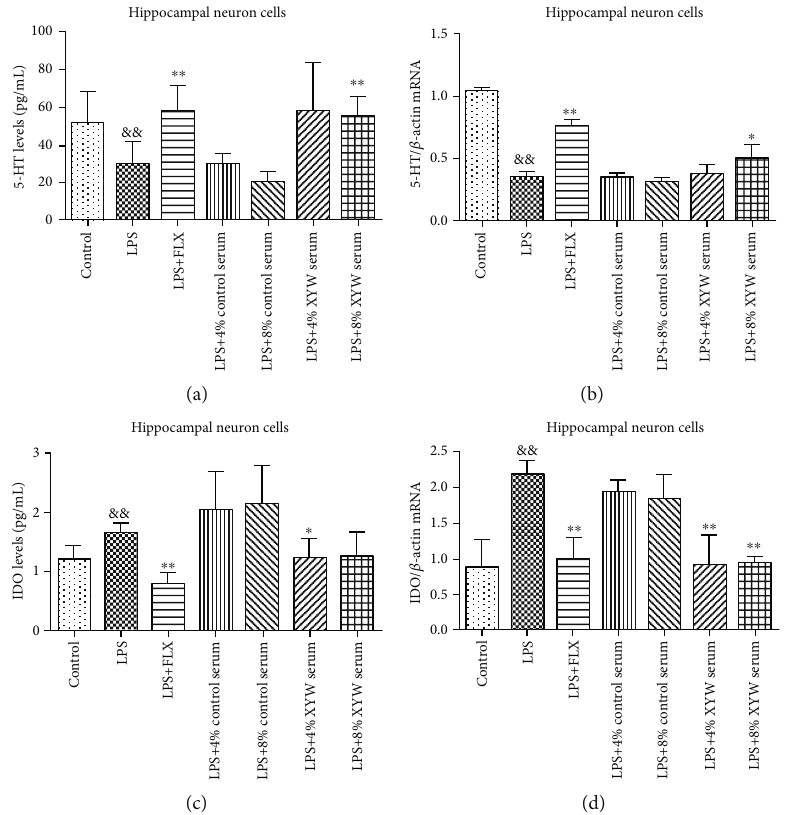
Figure 3: Xiaoyao Pill serum improved the expression of 5-HT and lowered the expression of IDO in hippocampal neuronal cells. The protein levels of 5-HT in cell lysate (a). The relative mRNA expression of 5-HT in cell lysate (b). The protein levels of IDO in cell lysate (c). The relative mRNA expression of IDO in cell lysate (d). The results were expressed as the mean ± SD ( n = 4 ‐ 6 ). && p < 0 : 01 compared to the control group. ∗ p < 0 : 05 and ∗∗ p < 0 : 01 compared to the LPS